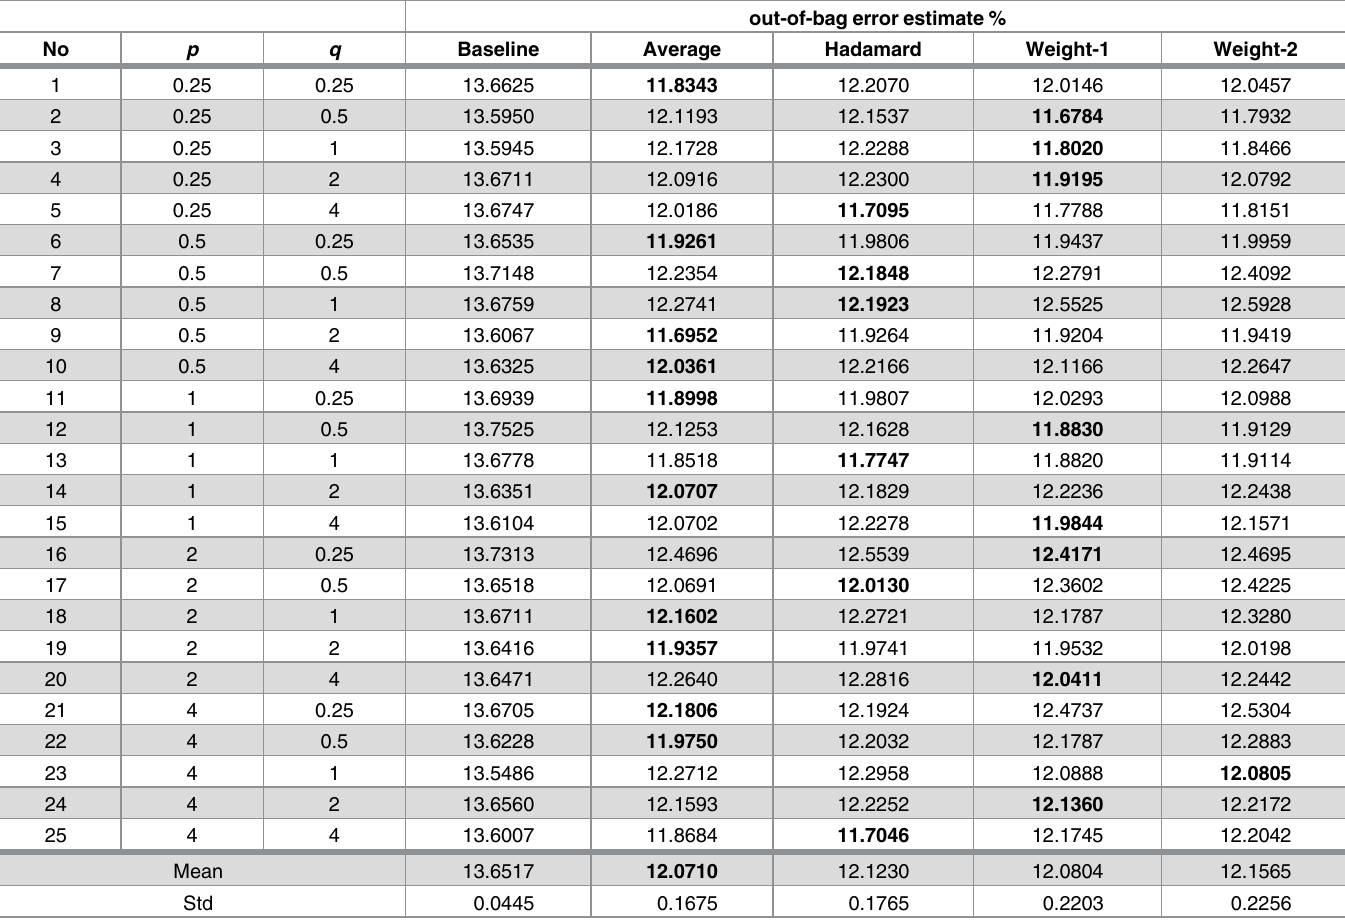
Table 6. Oob error estimatesfor the five analysis